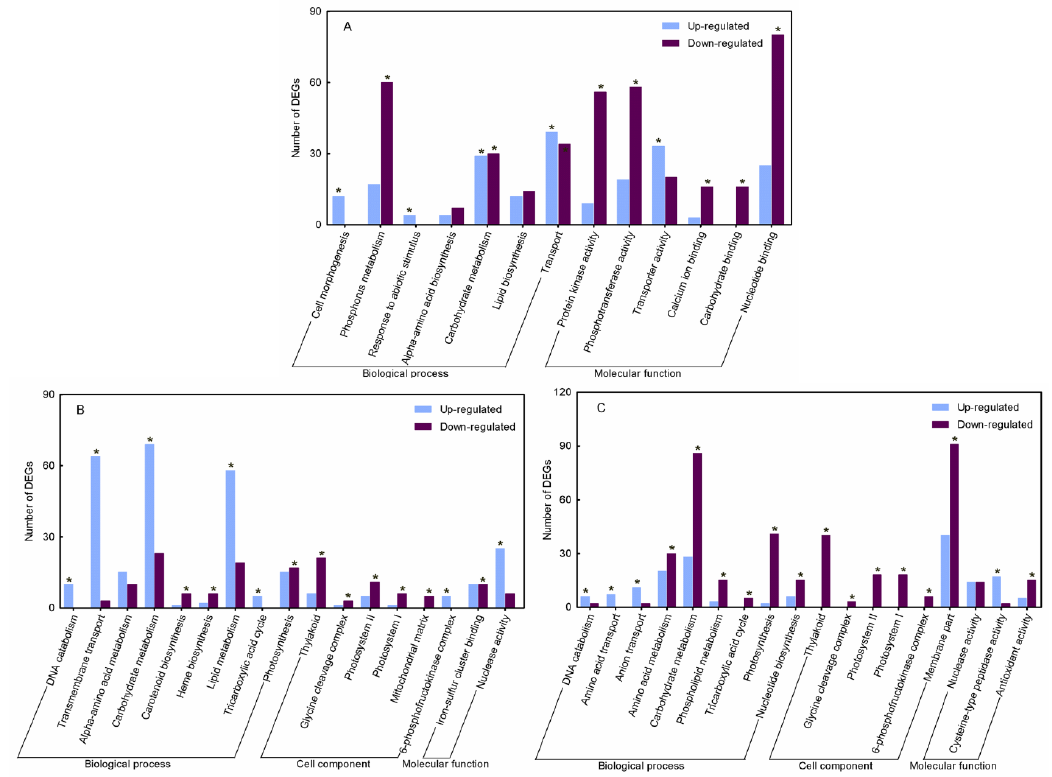
Figure 1. Enrichment analysis of GO terms in three sequential periods. ( A ) 0–15 DAA. ( B ) 15–25 DAA. ( C ) 25–30 DAA. “*”: Significantly enriched GO terms, p <